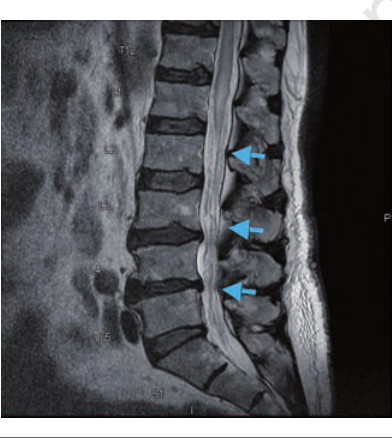
Figure 5. Axial T2 sequence shows hyper intense T2 signal in the central aspect of the thoracic spinal cord with several prominent intradural flow voids (arrow).